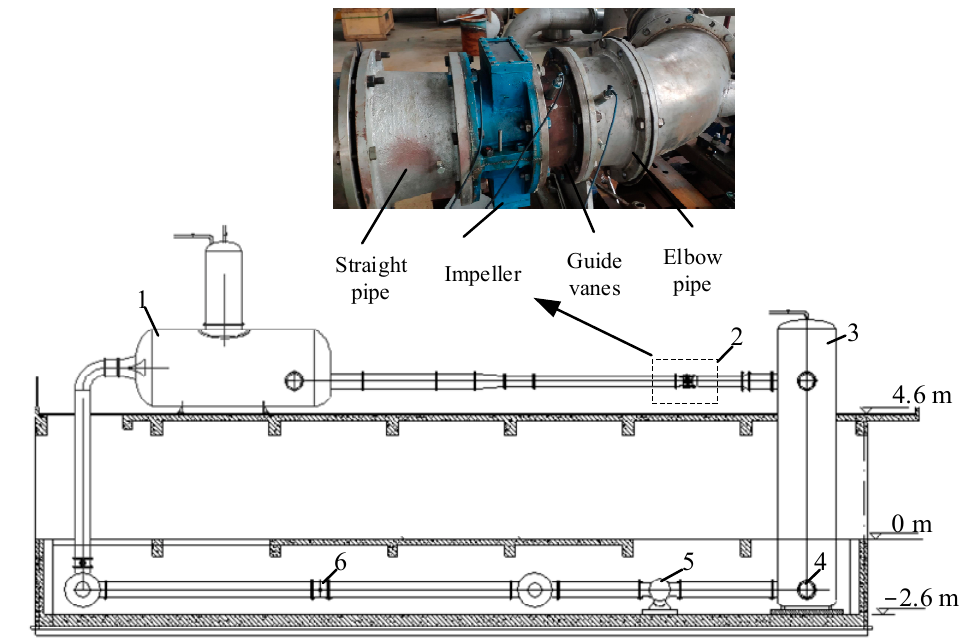
Figure 8. The structure of test bench. (1: high-pressure tank, 2: bidirectional axial-flow pump, 3: low-pressure tank, 4: valve, 5: valve, 6: valve).